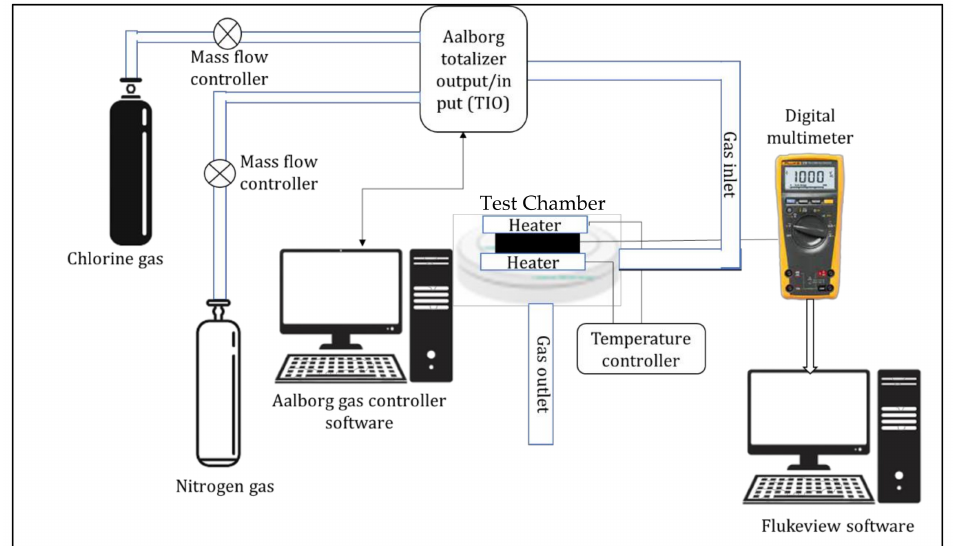
Figure 4. Sensor test